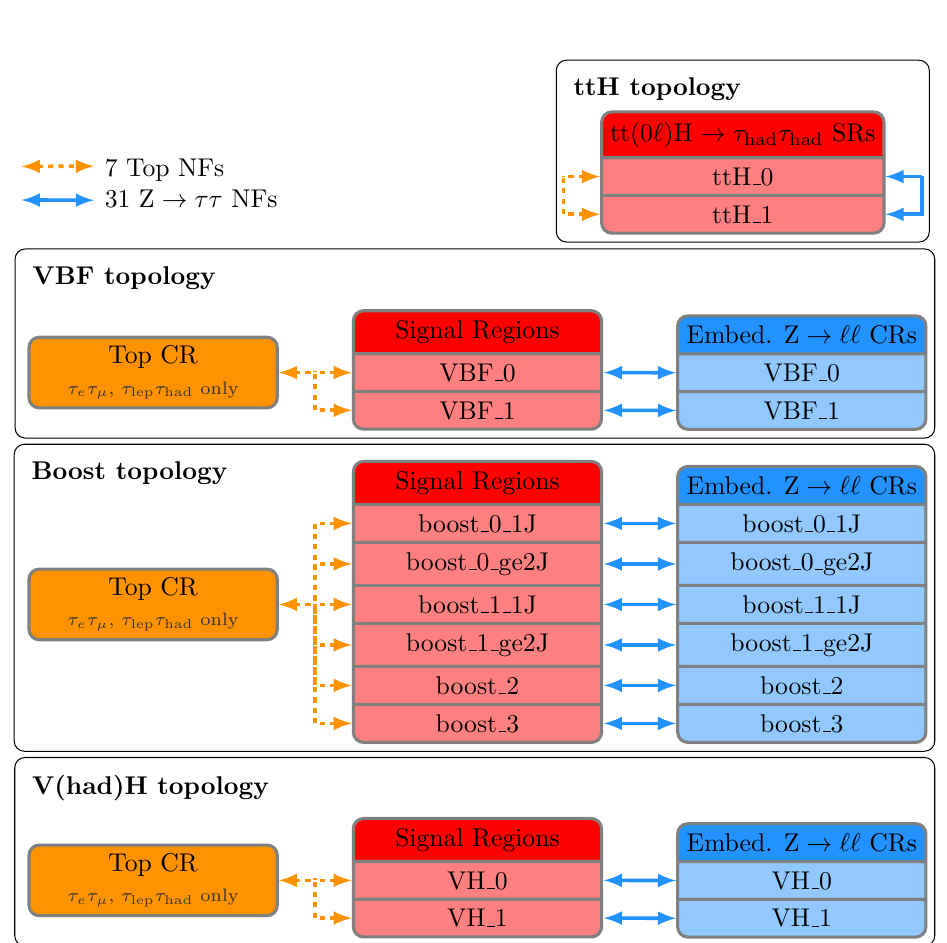
Figure 7. Graphical representation of the regions considered in the likelihood function and the normalisation factors (NFs) defined in the analysis. The four unfilled black boxes represent the four main topologies targeted in this measurement. Within each unfilled black box, the dark filled coloured boxes represent from left to right, the Top control regions, the signal regions and the Z → ‘‘ control regions. When applicable the subcategories are represented by a light filled colour. Each blue solid arrowed-line represents a normalisation factor that applies to the Z ( → ττ ) + jets process in the signal regions and to the Z ( → ‘‘ ) + jets process in the Z → ‘‘ control regions. Each orange dashed arrowed-line represents a normalisation factor that applies to the top processes in the signal regions and to the top processes in the Top control regions. The arrow ends of each line indicate which regions are connected by each normalisation factor. In the likelihood function, there are signal regions and Z → ‘‘ control region for each final state in the VBF, boost and V(had)H topologies. Therefore, the ten signal regions and Z → ‘‘ control regions are repeated three times. The Top control regions are only used in the τ τ and τ τ final states. Additionally, only one e µ lep had Top control region is considered by each